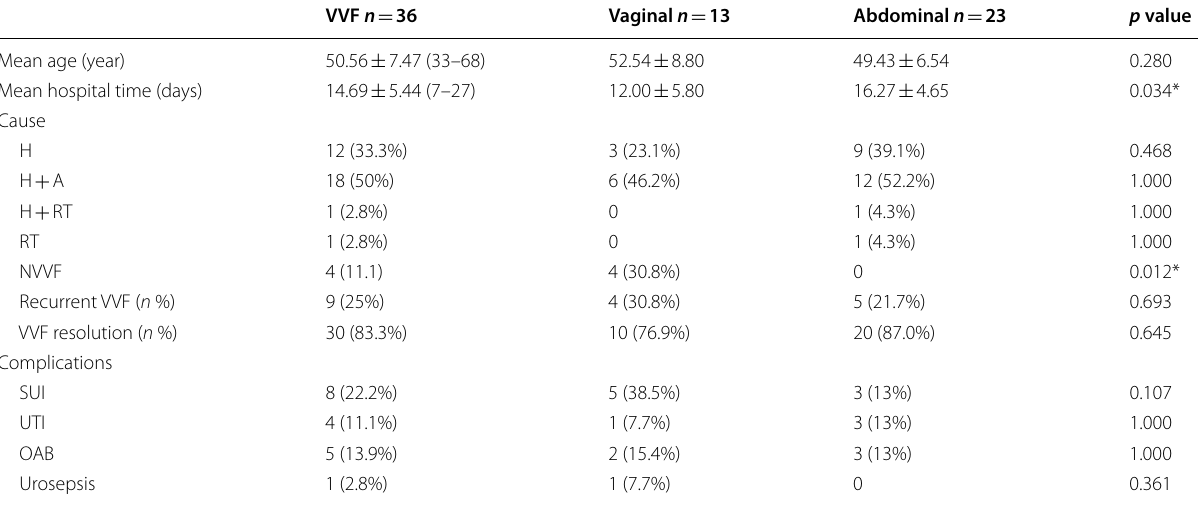
VVF vesicovaginal fistula, H hysterectomy, H SUI “stress” urinary incontinence, UTI urinary tract infection, OAB overactive